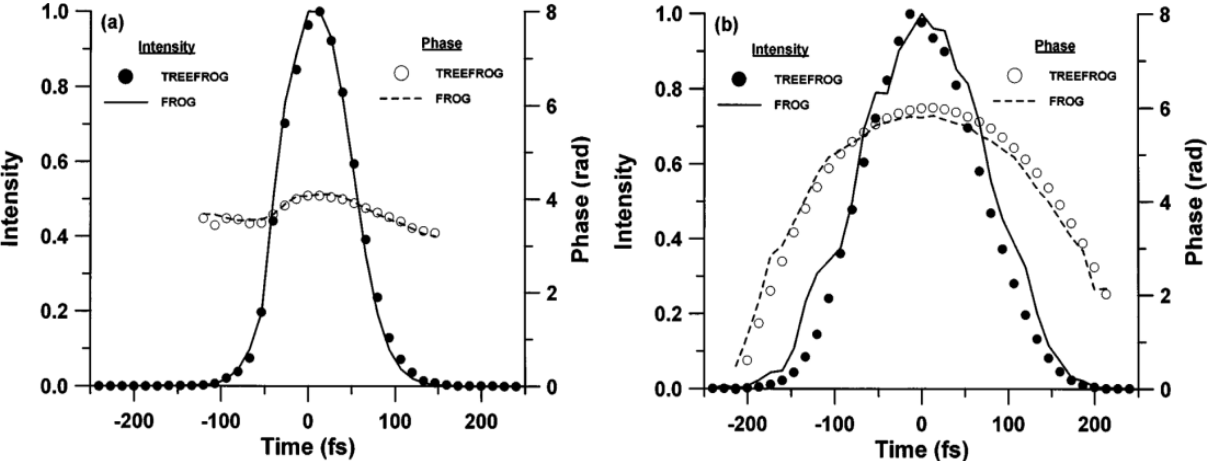
Figure 2. Electric fields of two pulses with different amount of chirp retrieved by second harmonic generation (SHG) Blind FROG (circles) compared with results retrieved by SHG FROG (lines)